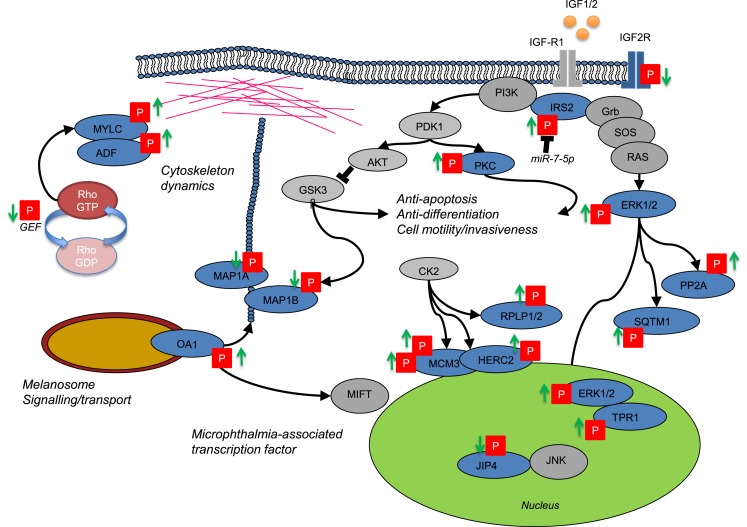
Network cartoon summarizing the prominent differences in phosphorylation measured between BRAFi sensitive and resistant cell populations.